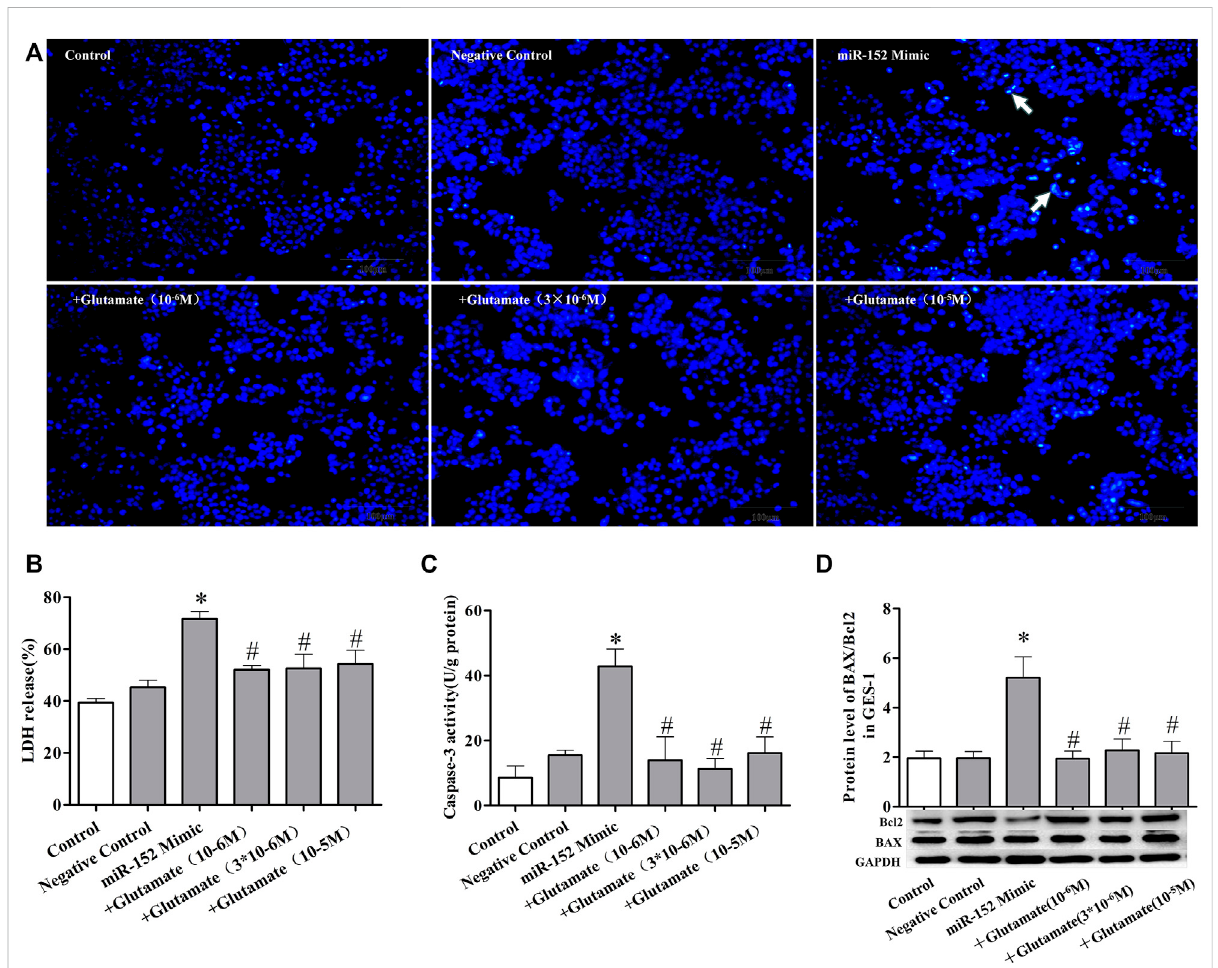
FIGURE 6 Cell damage induced by miRNA mimics can be attenuated by exogenous glutamate supplementation. (A) Protective effect of glutamate on gastricmucosalepithelialcellapoptosisaftertreatmentwithmimicmiR-152(Hoechststaining,×100). (B) LDHrelease. (C) Caspase-3activity. (D) The ratio of BAX/Bcl-2 in gastric mucosal epithelial cells. Data are expressed as mean ± standard error ( n = 3). # p < 0.05 vs. MicroRNAs mimic, * p < 0.05 vs. Negative